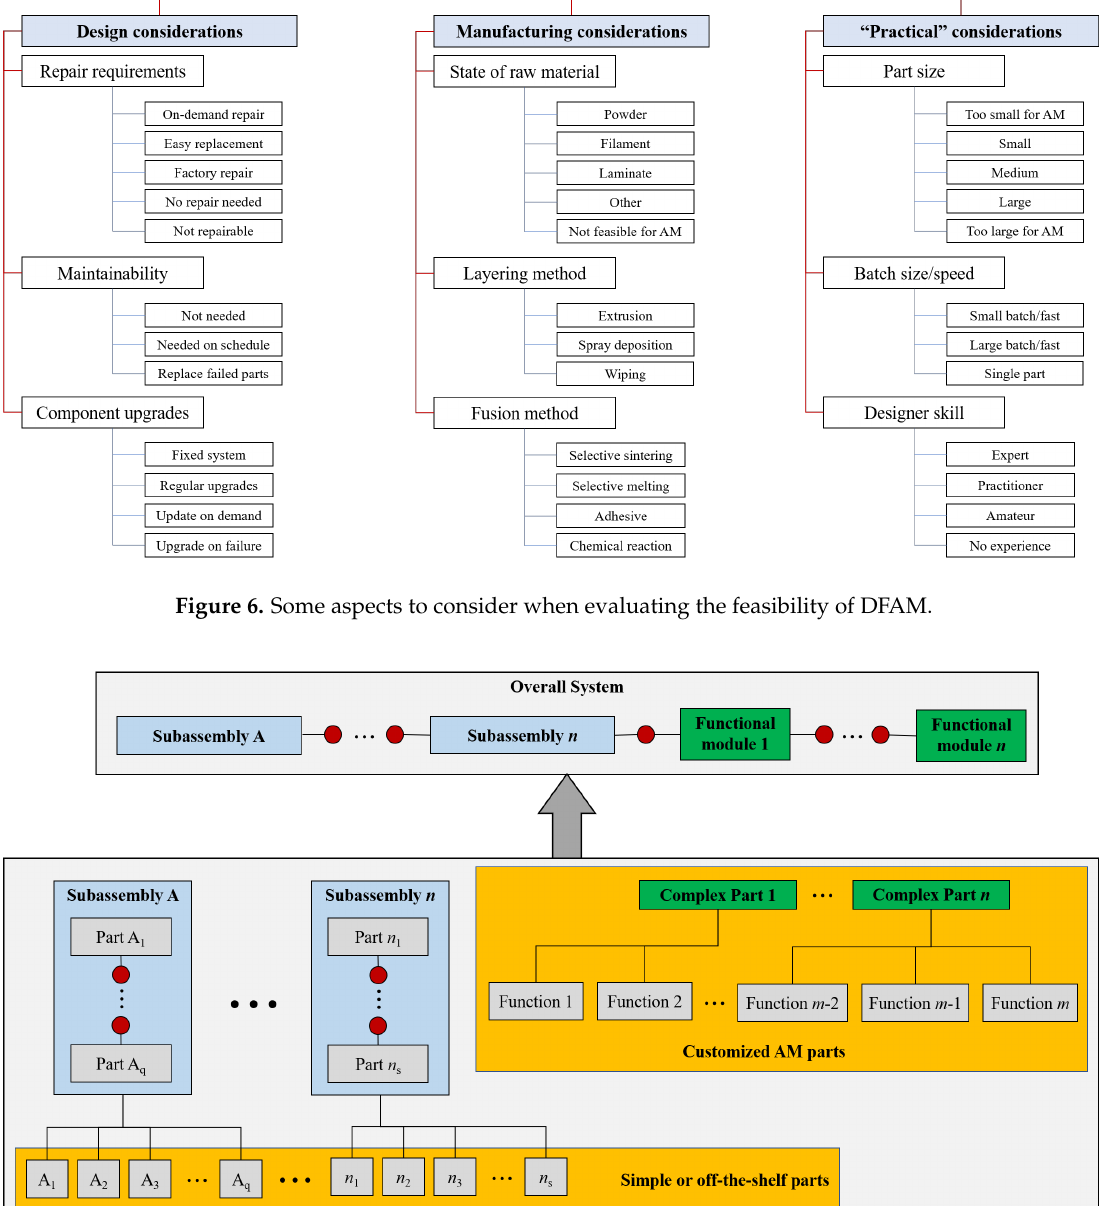
Figure 7. Hybrid subassembly-AMEMD system design